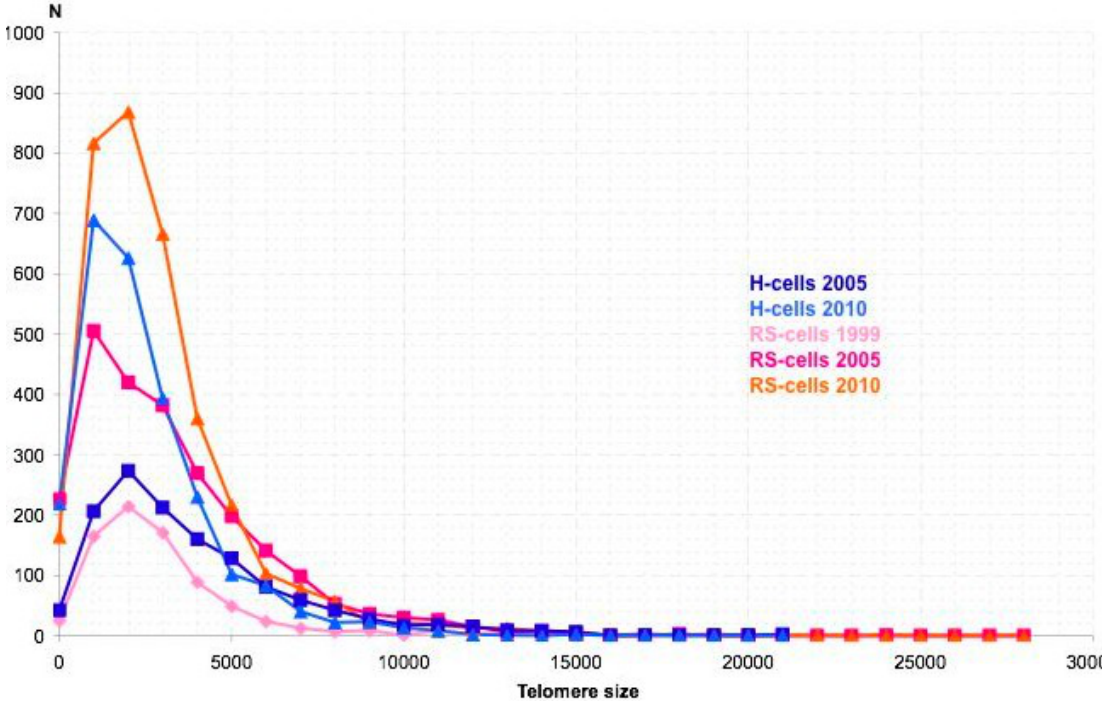
Figure 5. Typical telomere profiles associated with relapsing and finally refractory disease. Telomere distribution according to size in mononuclear H-cells and bi/multinuclear RS- cells. Results are based on 3D analysis of 30 Hodgkin and 30 Reed-Sternberg cells in a 5μm lymph node section of each diagnostic biopsy. Frequency (y-axis) and relative fluorescent intensity, i.e. , size of telomeres (x-axis), are plotted against each other. As a particularity, the initial diagnostic biopsy had numerous RS-cells but only few H-cells and the number of aggregates was low but increased fivefold in the last